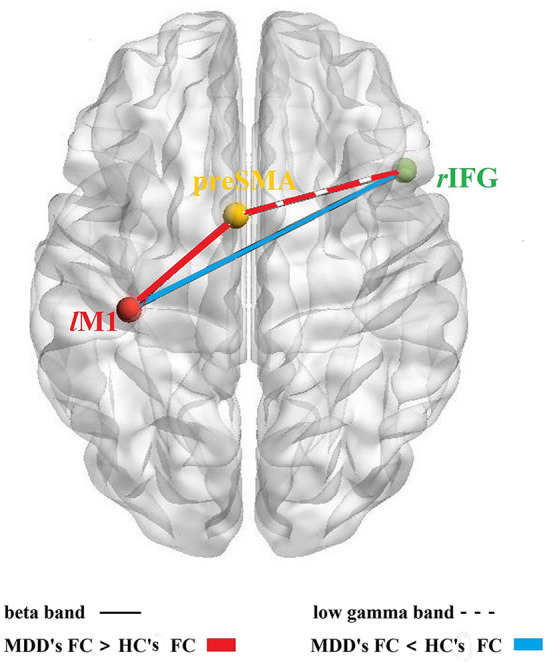
FC among rIFG-preSMA-lM1. Schematic diagram of the FC among the three core brain regions based on response inhibition network; solid lines: the FC in beta band, dotted line: the FC in the low gamma band; red color: MDD's FC > HC's FC, blue color: MDD's FC < HC's FC.